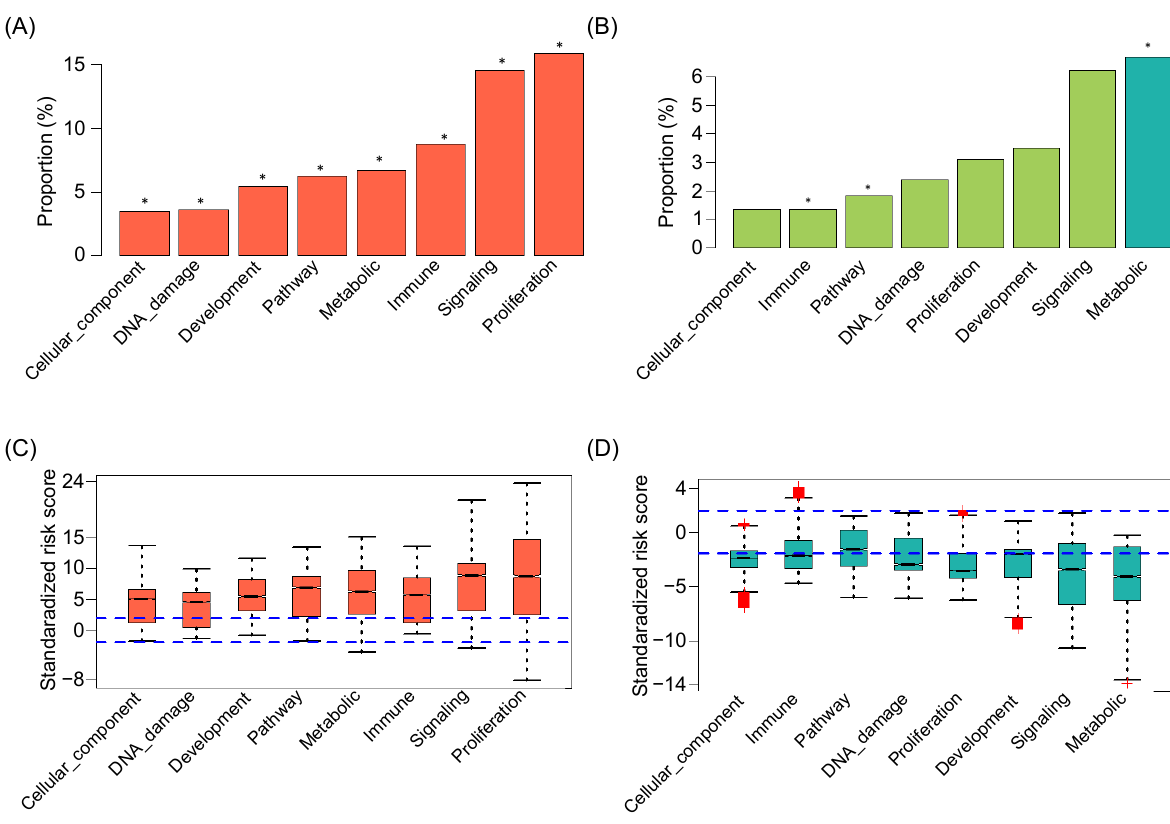
Figure 6. Enrichment analysis of pan-cancer SIGs in cancer-relevant hallmarks. ( A , B ) Overrepresentation or underrepresen- tation of pan-cancer harmful ( A ) and protective ( B ) genes in MsigDB hallmark gene sets. The x -axis shows the MSigDB hallmark category. The y -axis shows the proportion of the pan-cancer harmful ( B ), and protective ( C ) genes of the total genes in the MSigDB category. Dark and light bars represent overrepresentation and underrepresentation, respectively. An asterisk signifies a significant proportion of pan-cancer SIGs ( p -value < 0.05, Fisher’s exact test) in the corresponding hallmark category. ( C , D ) Risk score of pan-cancer harmful ( C ), and protective ( D ), SIGs in the MSigDB category compared to overall patient survival. Positive scores represent a high expression level of genes significantly associated with poor survival, and negative scores indicate better survival. The dashed lines represent an absolute standardized risk score value of ± 1.96 (corresponding to a p -value <